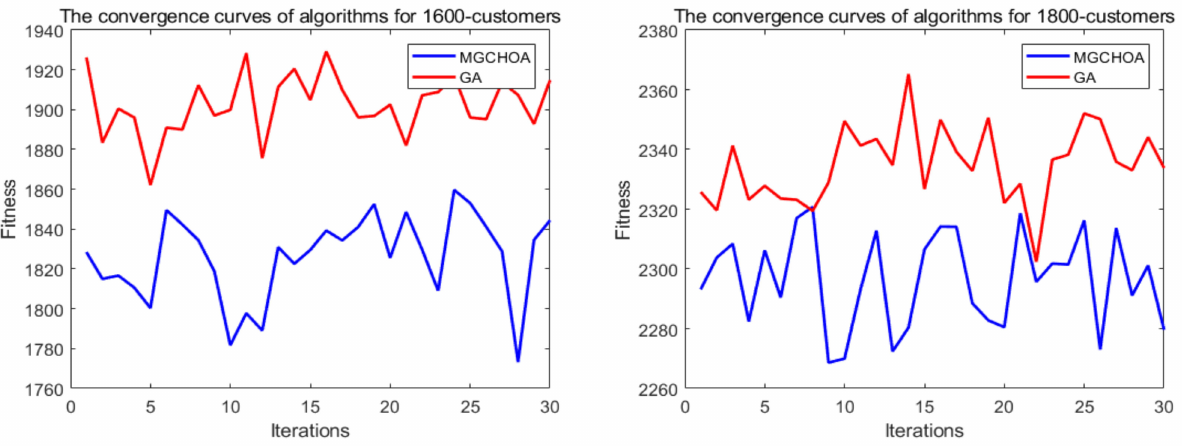
Figure 20. The results of 30 runs of the algorithms, the blue box denotes the data distribution, the red line represents the median value, and the red symbol denotes the abnormal value.